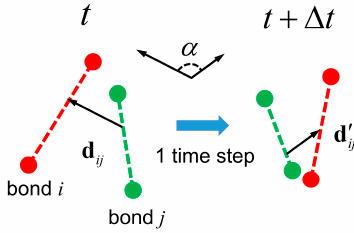
Figure 8. Schematic of a topology violation, where the minimum distance vector between bonds changes orientation by an angle larger than 90° in one time step. Red and green colors represent different bonds.